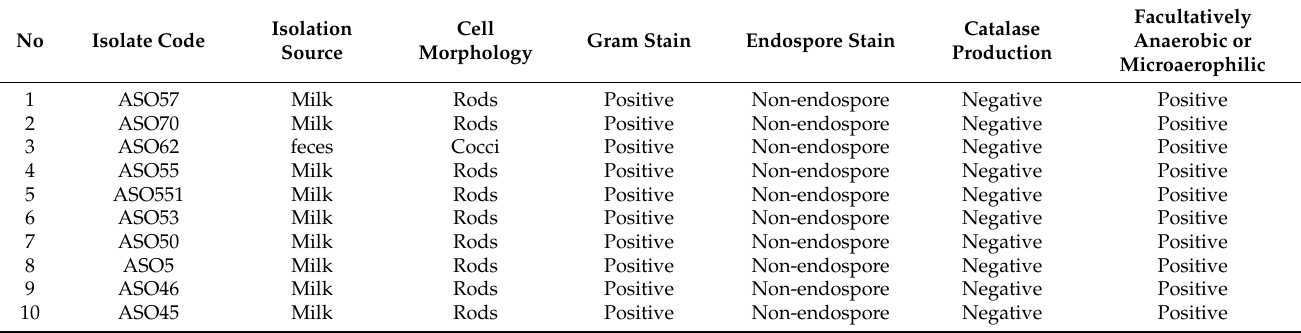
Table 1. Morphological properties of lactic acid bacterial